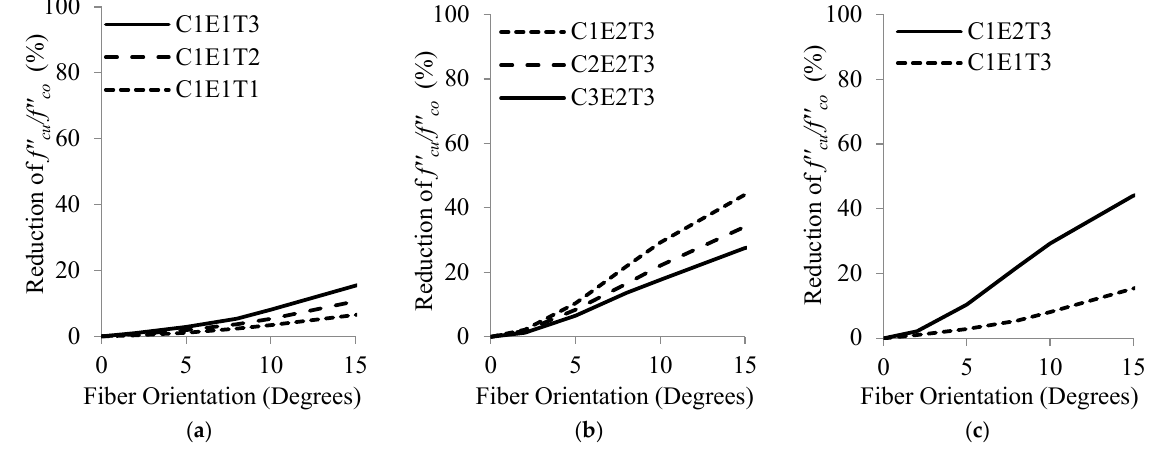
Figure 7. Variations of 𝑓 (cid:3030)(cid:3048)(cid:4593) /𝑓 (cid:3030)(cid:3042)(cid:4593) versus fiber orientation for selected specimens: ( a ) for 𝑡 (cid:3033)(cid:3045)(cid:3043) from 0.2 to 1.0 mm, ( b ) for 𝑓 (cid:3030)(cid:3042)(cid:4593) from 20 to 50 MPa and ( c ) for 𝐸 (cid:3033)(cid:3045)(cid:3043) of 50 and 200 GPa. It is clear from Figure 7 that 𝑓 (cid:3030)(cid:3048)(cid:4593) /𝑓 (cid:3030)(cid:3042)(cid:4593) decreased substantially as 𝜃 increased. It could be observed that this reduction was positively associated with the 𝐸 (cid:3033)(cid:3045)(cid:3043) and 𝑡 (cid:3033)(cid:3045)(cid:3043) , and was negatively associated with the 𝑓 (cid:3030)(cid:3042)(cid:4593) . In other words, specimens which exhibited higher enhancement in 𝑓 (cid:3030)(cid:3048)(cid:4593) /𝑓 (cid:3030)(cid:3042)(cid:4593) with hoop fibers (i.e., specimens with higher 𝐸 (cid:3033)(cid:3045)(cid:3043) and 𝑓 (cid:3030)(cid:3042)(cid:4593) ), showed higher reduction in 𝑓 (cid:3030)(cid:3048)(cid:4593) /𝑓 (cid:3030)(cid:3042)(cid:4593) with deviation in 𝜃 . A careful 𝑡 (cid:3033)(cid:3045)(cid:3043) , and lower